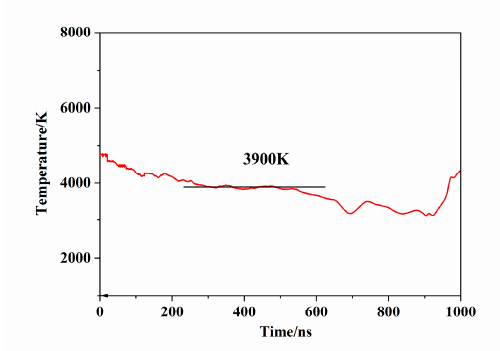
Figure 5. The fitting temperature.